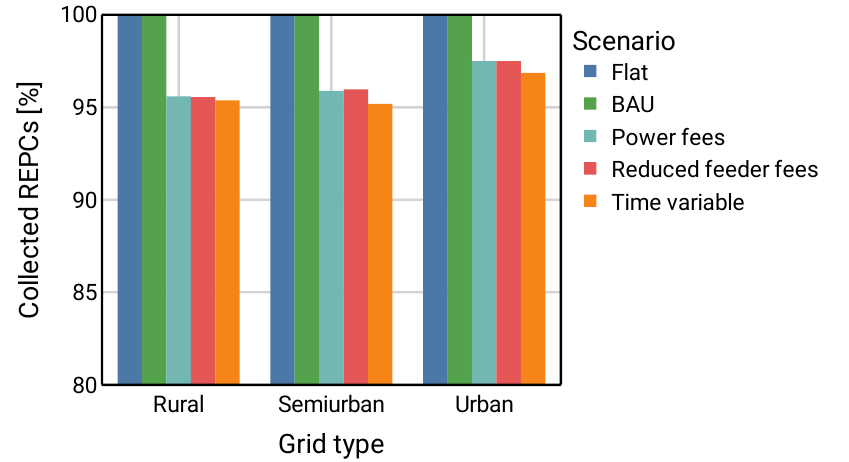
Figure 12. Average asset-specific benefit compared to the business-as-usual scenario for a variation of grid tariff designs/fee scenarios, the semiurban grid and the scenario year 2035.